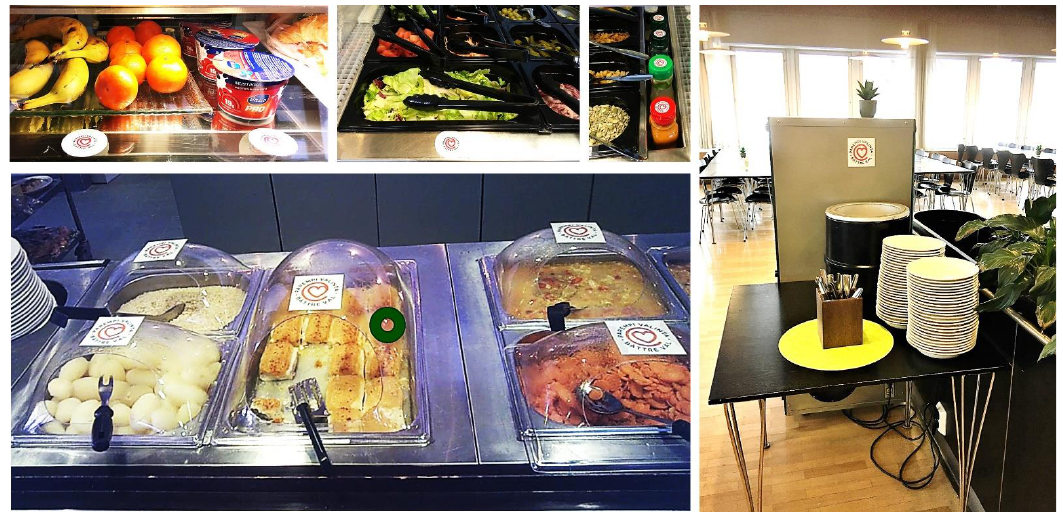
Figure 4. Examples of labelled heart-food items during the intervention. The dark green circle on the bo ttom left image indicates the point of a participant’s fixation. Images reproduced with the permission of the study cafeteria.